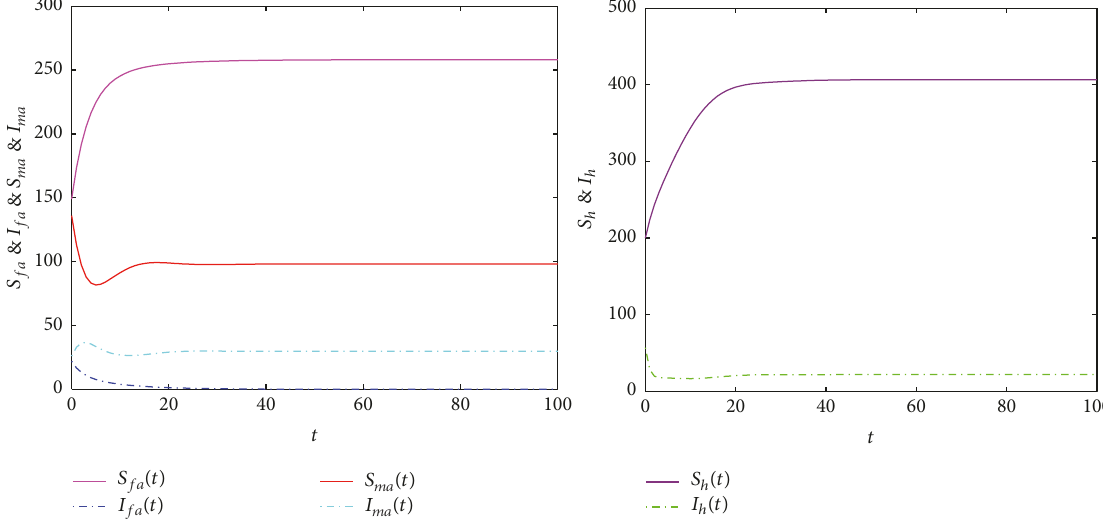
Figure 3: If 𝑅 01 = 0.82949309 < 1 and 𝑅 02 = 1.83929618 > 1 , the time-variation diagram of system (25) state variables is